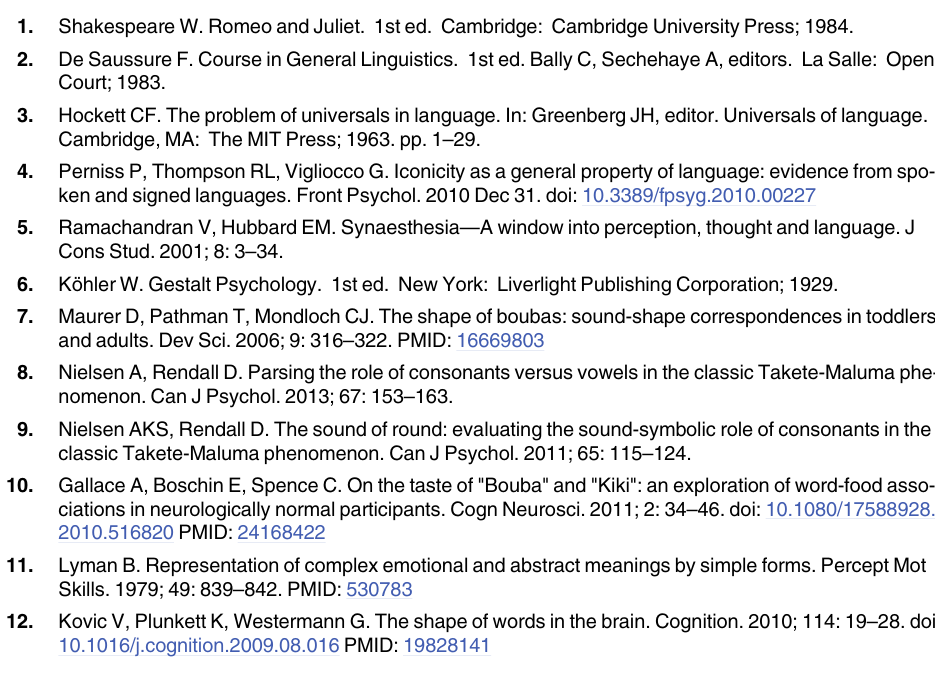
S2 Table. Summary of the maximally complex logistic regression model in Experiment 1a predicting the likelihood of round silhouette selection. S3 Table. Summary of the maximally complex logistic regression model in Experiment 1b predicting the likelihood of round silhouette selection. S4 Table. List of Adjectives Used in Experiment 2. List of metaphorically-round and meta- phorically-sharp adjective stimuli used in Experiment 2. S5 Table. List of Name Pairs Used in Experiment 2. List of name pairs used in Experiment 2 along with their frequency. S6 Table. Summary of the maximally complex logistic regression model in Experiment 2 predicting the likelihood of round name